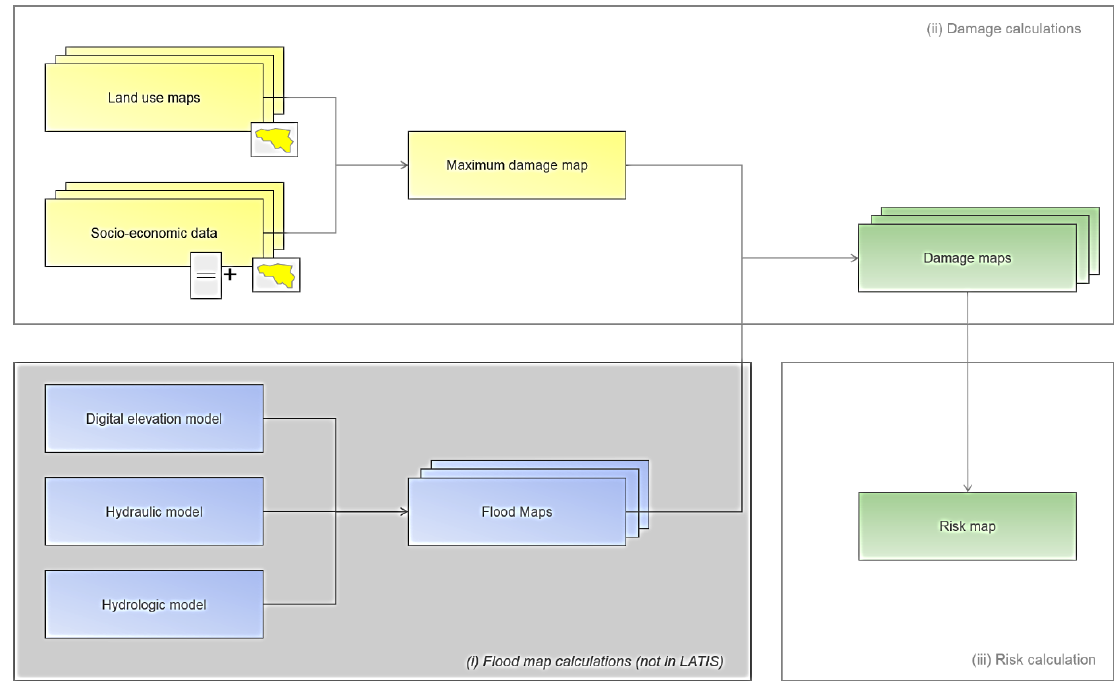
Figure 1. LATIS methodology to calculate the socio-economic damage and risk [10].